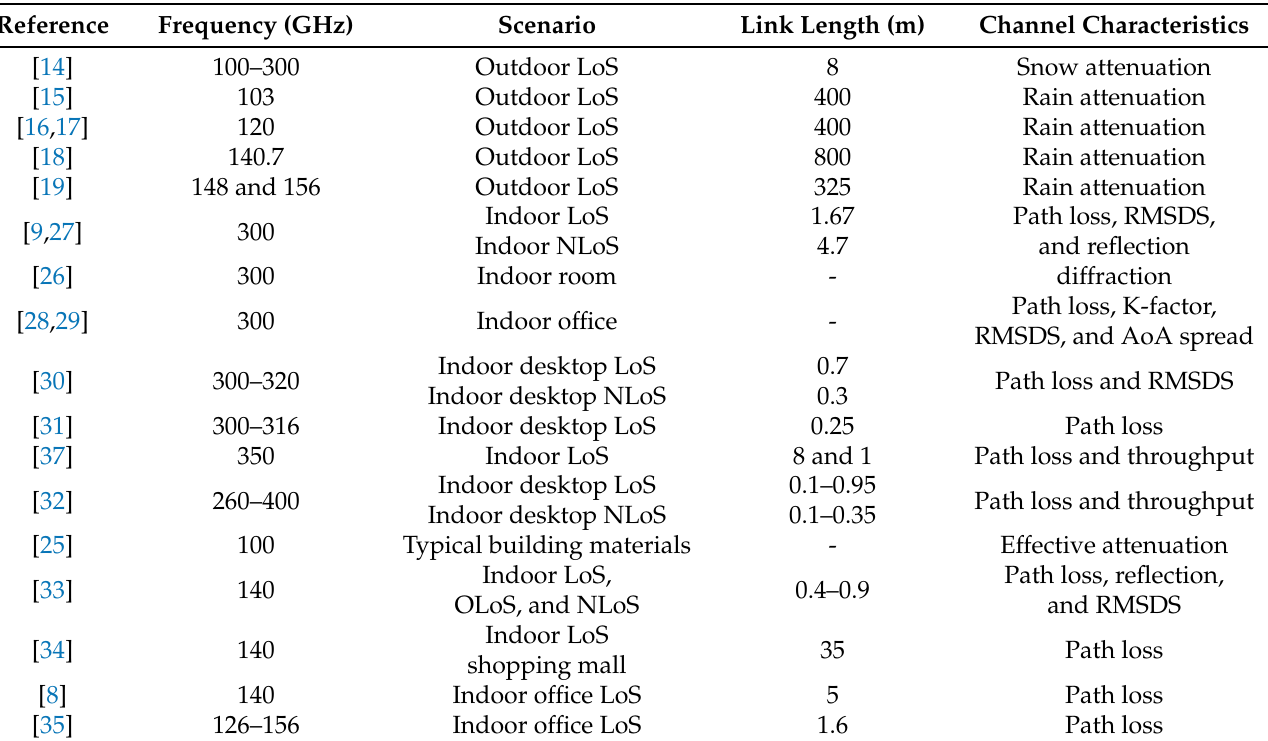
Table 1. Channel characterization studies in the 0.1–1 THz range. RMSDS, root mean squared delay spread.